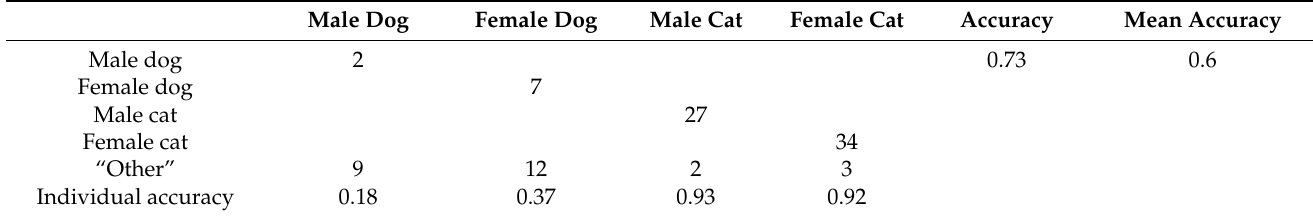
Table 13. The performance of Yolov3-Tiny majority voting for multi-classification.